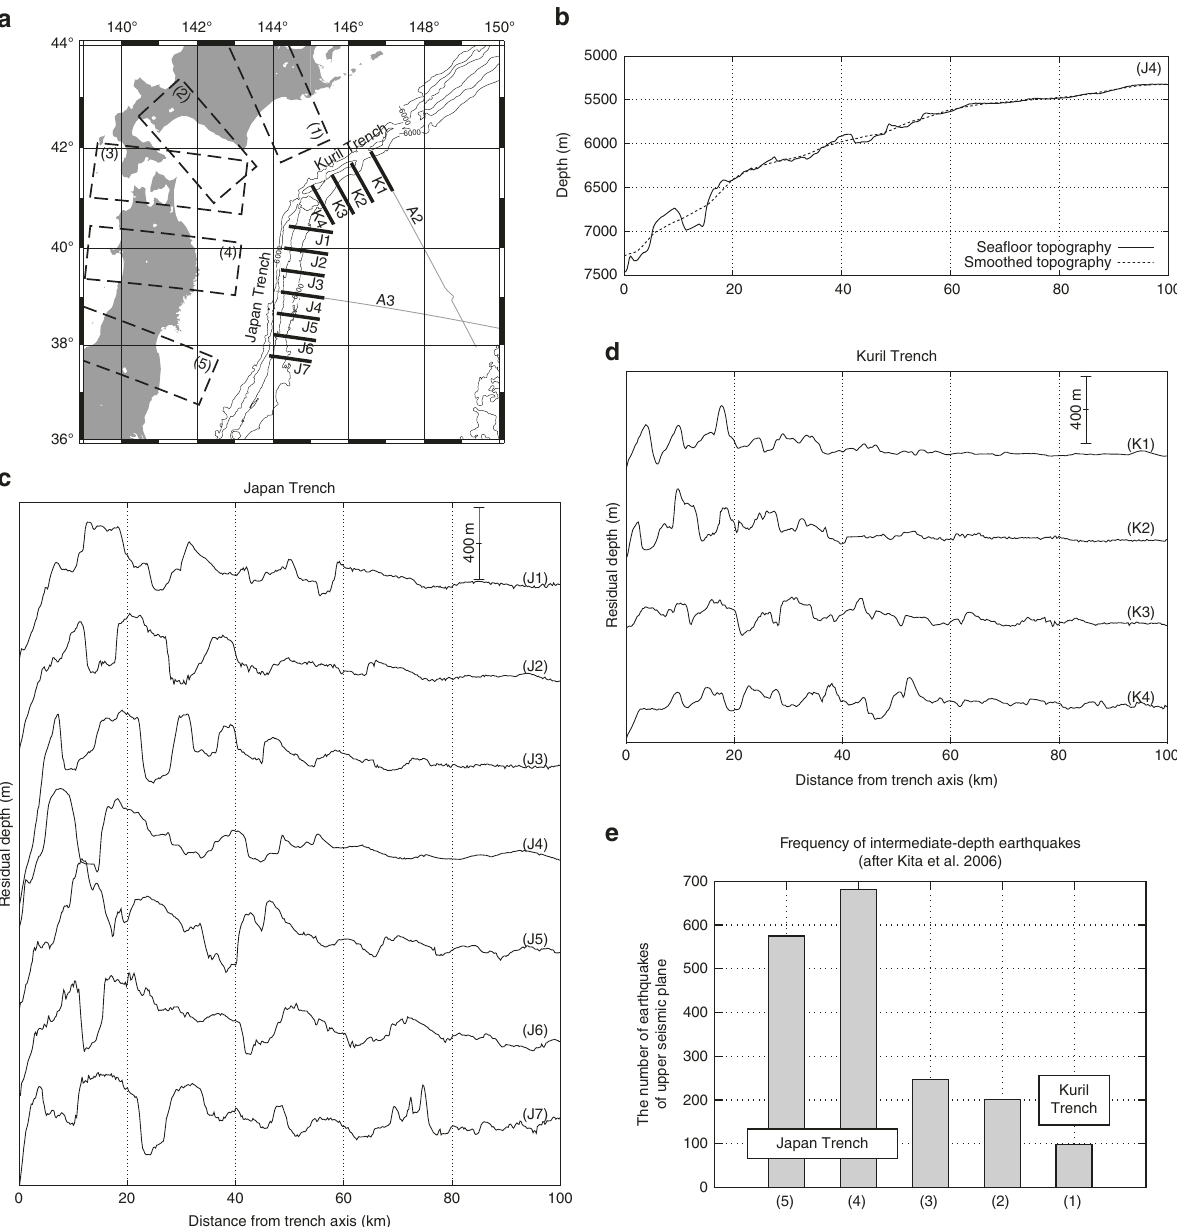
Fig. 2 Sea fl oor topography. a Location map. Solid lines K1-K4 and J1-J7 are the locations of the sea fl oor topographic pro fi les shown in b – d , and boxes 1-5 are the areas for evaluating the frequency of the earthquakes in e . b Sea fl oor topography along pro fi le J4: raw data (solid) and smoothed data (dashed). Smoothing was performed with a moving average spatial fi lter. c Sea fl oor topography after removing the trend, de fi ned by difference between raw and smoothed data, in the Japan Trench. The horizontal axis is the distance from the trench axis. The throw of horst and graben reaches more than 800 m near the trench axis. d Sea fl oor topography after removing the trend in the Kuril Trench. The throw is <400 m. e Frequency of dehydration-induced intermediate-depth earthquakes after subduction 24 . The number of earthquakes was calculated for each box (1) – (5). The vertical axis shows the peak of the upper plane earthquake frequency. The activity of dehydration-induced earthquakes is remarkably higher in the Japan Trench than in the Kuril